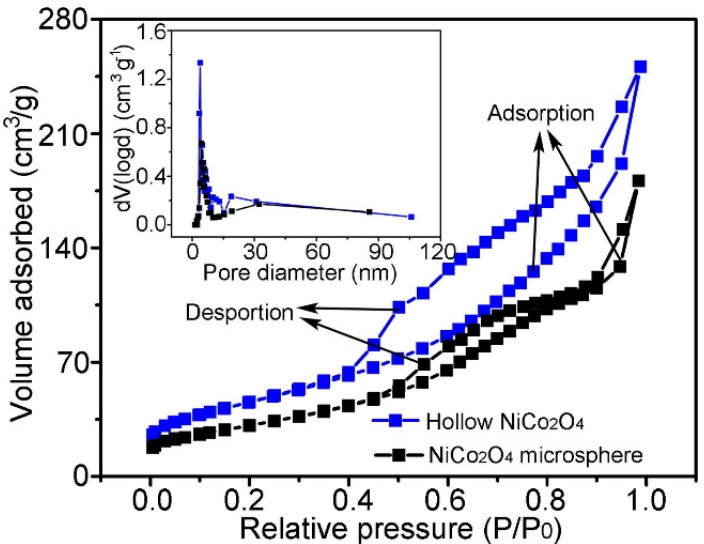
Figure 3. Nitrogen adsorption–desorption isotherms of hollow NiCo 2 O 4 nanospheres and NiCo 2 O 4